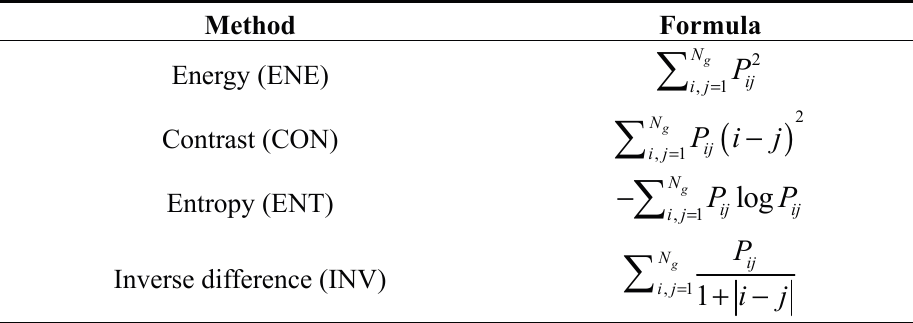
Table 1. The GLCM features used in this